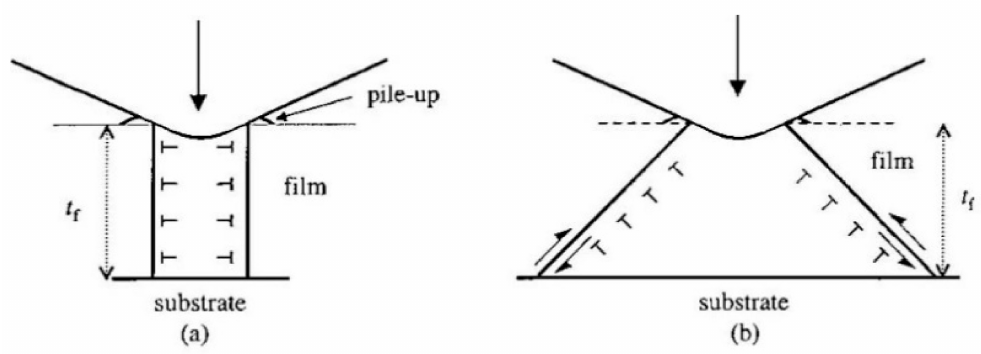
Figure 2. Two scenarios for dislocation nucleation beneath an indenter. ( a ) Punching of a PDL with a diameter equal to the indenter sample contact area, and ( b ) shear-band formation with a shear dislocation loop (including a half one) nucleating and gliding into a deeper region